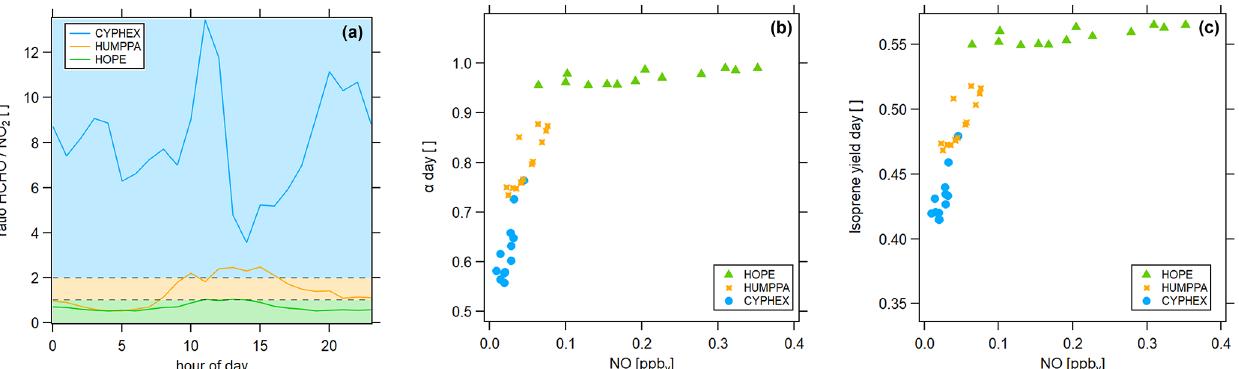
Figure 11. Determination of the dominant chemical regime via (a) the HCHO / NO 2 ratio (colored areas indicate the dominant chemical regime, according to Duncan et al. (2010), which are blue (HCHO / NO 2 > 2) for a NO x limitation, green (HCHO / NO 2 < 1) for a VOC limitation and yellow (1 < HCHO / NO 2 < 2) for the transition), (b) the fraction of methyl peroxy radicals forming HCHO and (c) the HCHO yield from